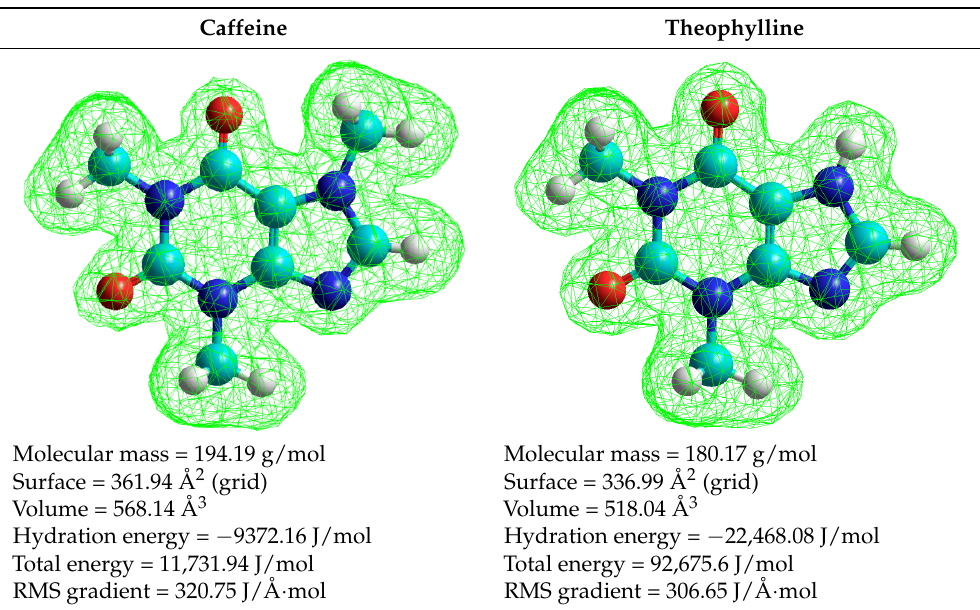
Table 1. Optimized molecular structures representing ball shape and their properties.